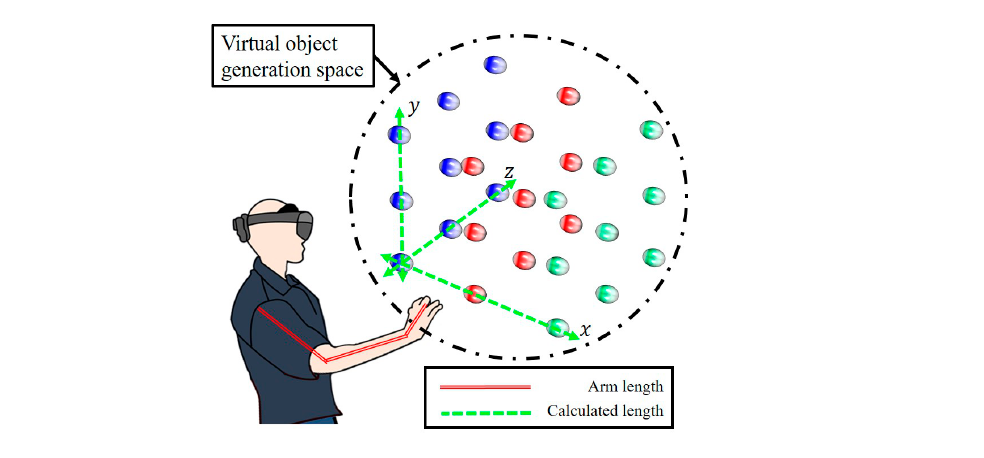
Figure 8. The experimental environment allows a user to see and interact with virtual objects in the virtual object generation space (the dotted circle).